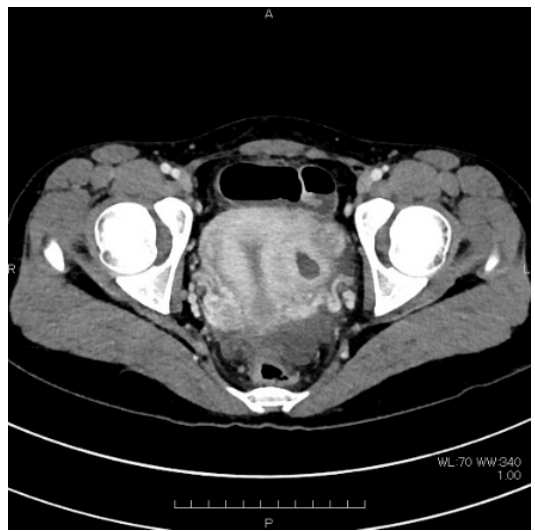
Figure 2. Pelvic contrast-enhanced computed tomography. Cystic shadow of 3 cm in diameter on the left wall of the uterus.